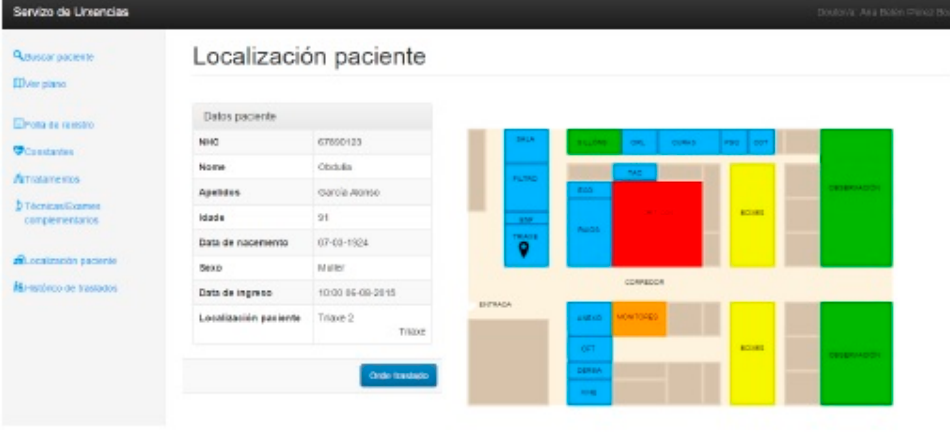
Figure 5. Emergency services area map for data acquisition and patient